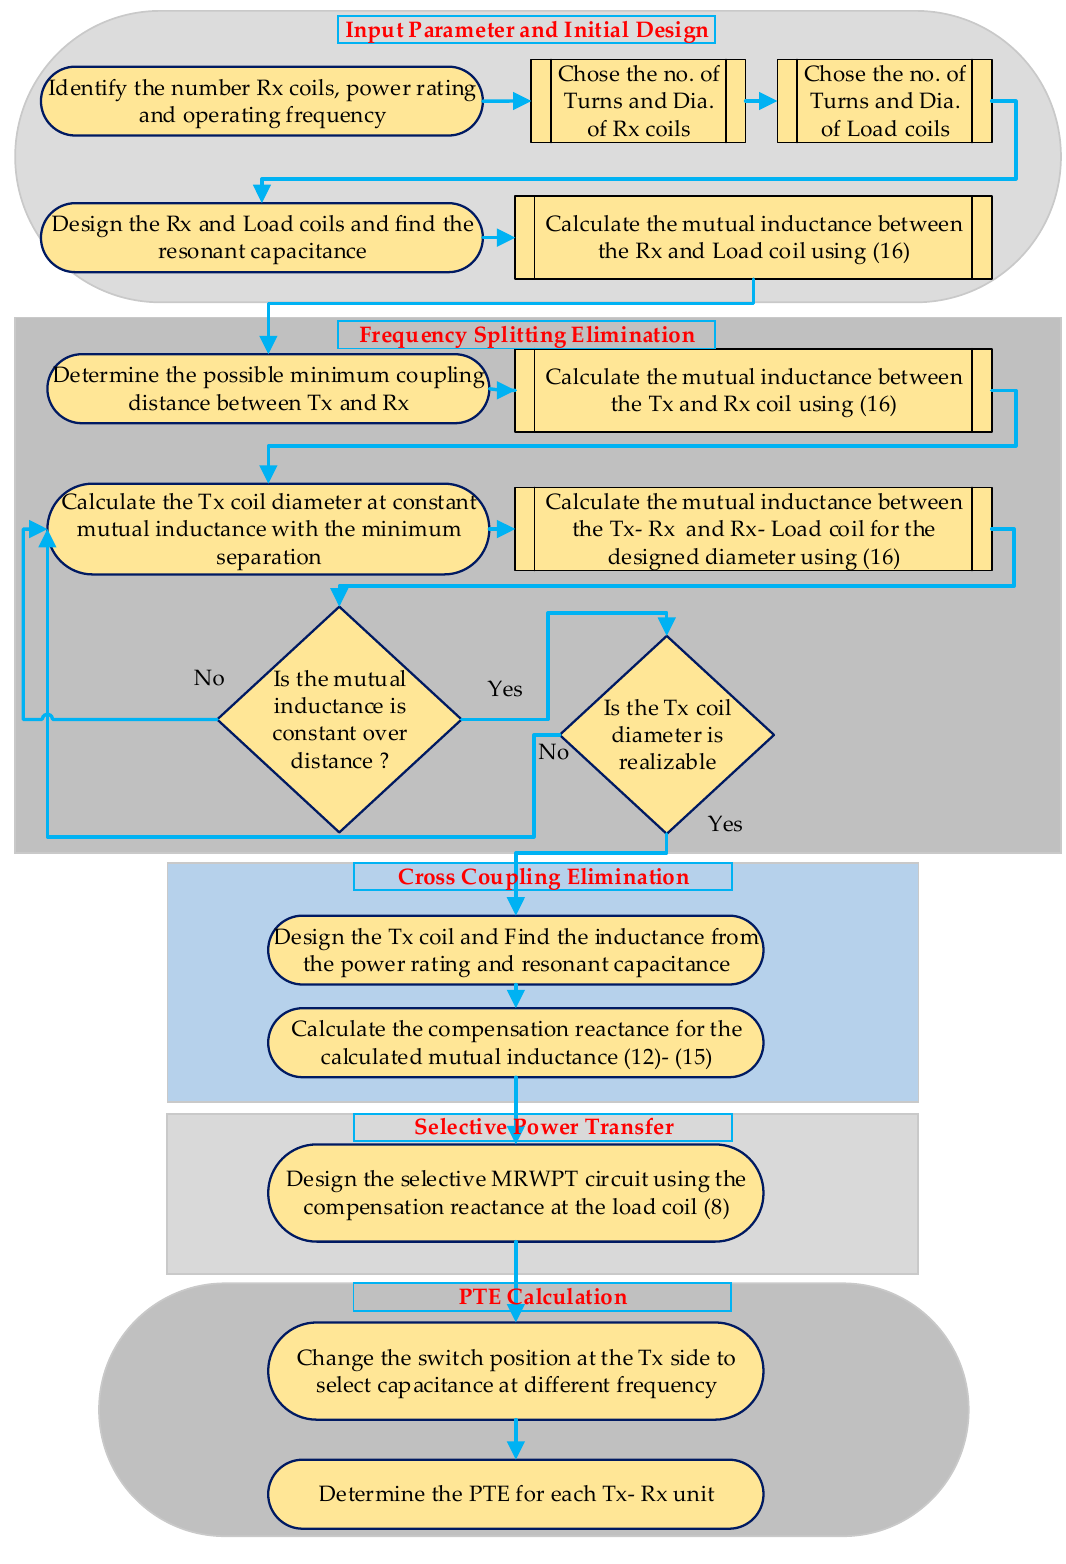
Figure 9. Design Flowchart of Proposed Method.